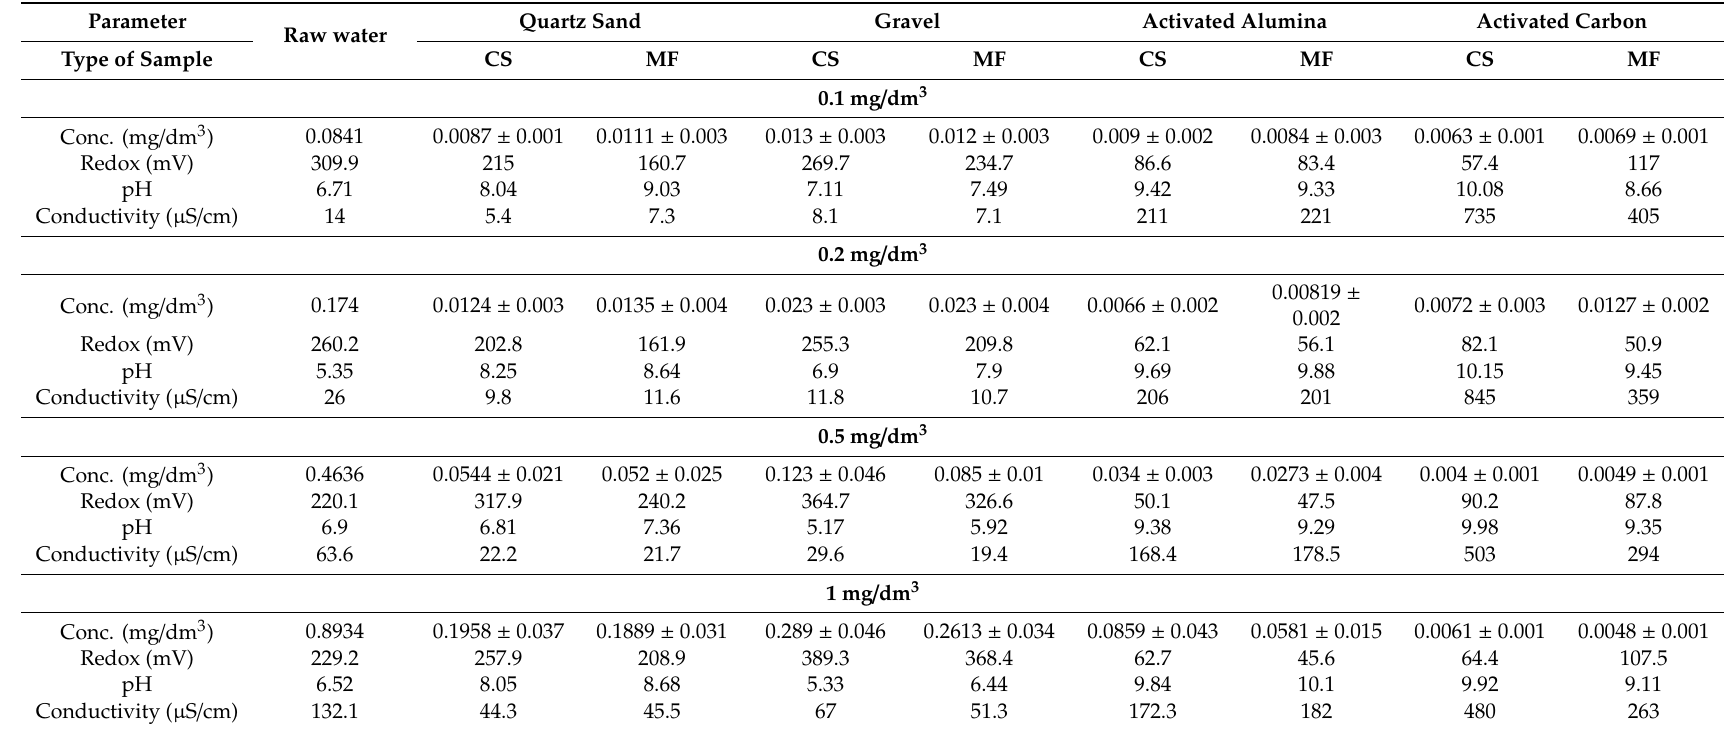
Table 4. Summary of results for samples containing